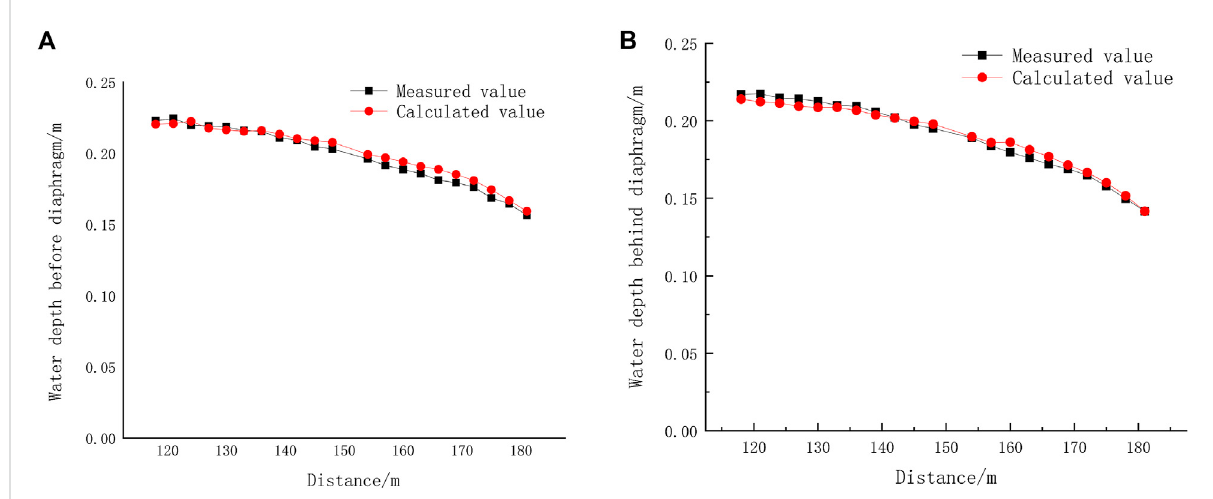
FIGURE 6 (A) Veri fi cation of the water depth before the diaphragm; (B) Veri fi cation of the water depth behind the diaphragm.